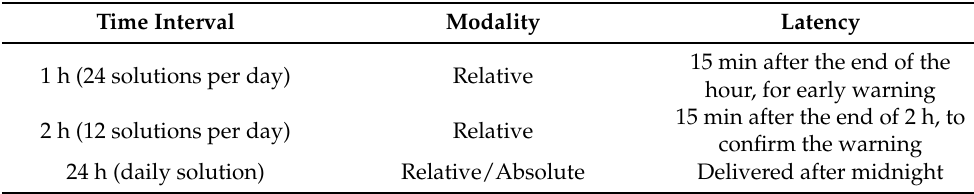
Table 1. Solutions continuously provided for the monitored